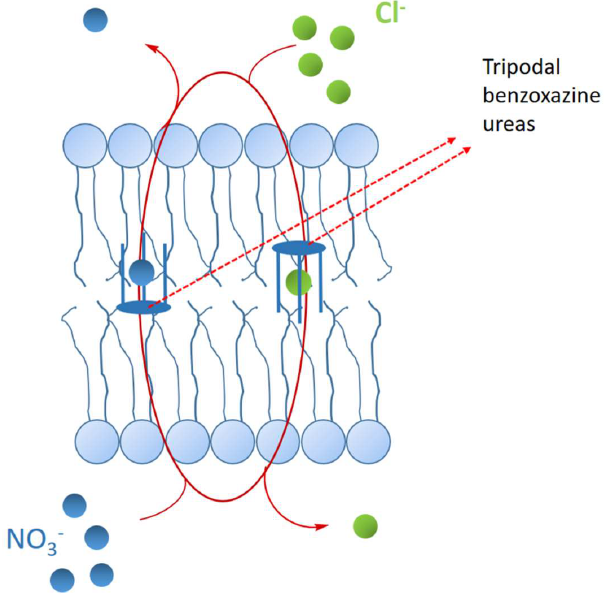
Figure 8. Representation of the C3-symmetric benzoxazine ionophores exchanging the anions trough liposomal membrane. liposomal